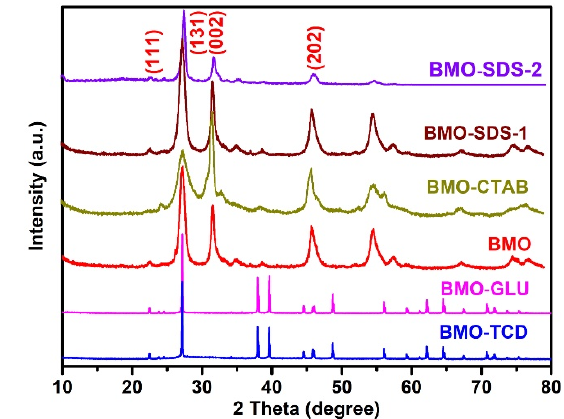
Figure 1. X-ray diffraction patterns of different Bi 2 MoO 6 samples, including, BMO-SDS-2 Figure 1. X-raydiffractionpatternsofdifferentBi 2 MoO 6 samples, including, BMO-SDS-2(sodium-dodecyl (sodium-dodecyl sulfonate), BMO-SDS-1 (sodium-dodecyl sulfate), BMO-CTAB sulfonate), BMO-SDS-1 (sodium-dodecyl sulfate), BMO-CTAB (cetyl-trimethyl-ammonium bromide), (cetyl-trimethyl-ammonium bromide), BMO (no surfactant), BMO-GLU (glucose), and BMO-TCD BMO (no surfactant), BMO-GLU (glucose), and BMO-TCD (trisodium citrate (trisodium citrate dehydrate).